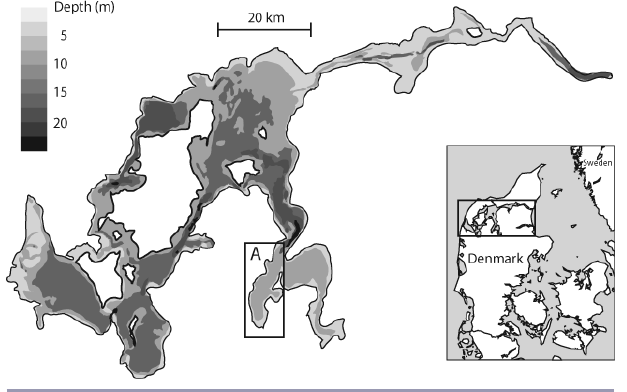
Fig. 1 . Map of the Limfjord area. The location of Skive Fjord is marked with an